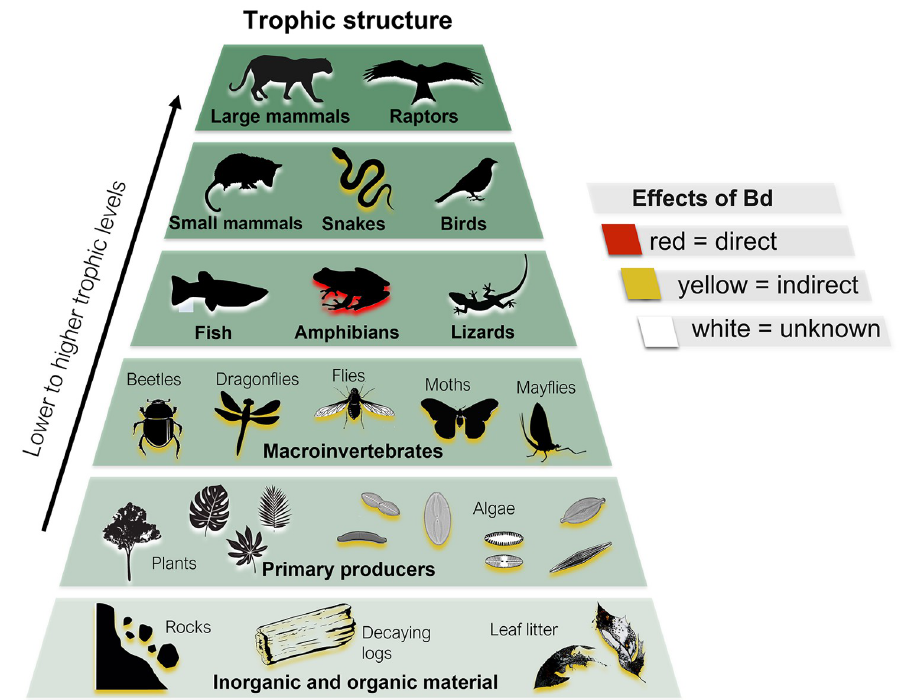
Fig 2. Trophic diagram showing the cascading effects of the Bd invasion in El Cope´, Panama. Following the arrival of Bd, amphibians experienced mass mortality from the direct effects of the disease (shadowed in red), which led to significant changes across the local ecosystem through cascading processes. Studies have documented both indirect bottom-up and top-down effects of Bd, including changes in the richness and composition of snakes as well as in the structure and functional diversity of macroinvertebrates, primary producers, and inorganic and organic material (shadowed in yellow). Additional taxa in the system (shadowed in white) could have also been impacted by the Bd invasion, but to date, there are no published studies on these taxonomic groups. Species groups shown at the various tropic levels are representative and not exhaustive.